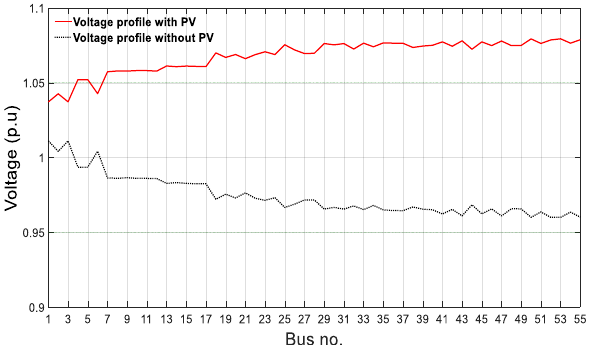
Figure 5. Overvoltage problem with PV systems at the peak PV production at 11